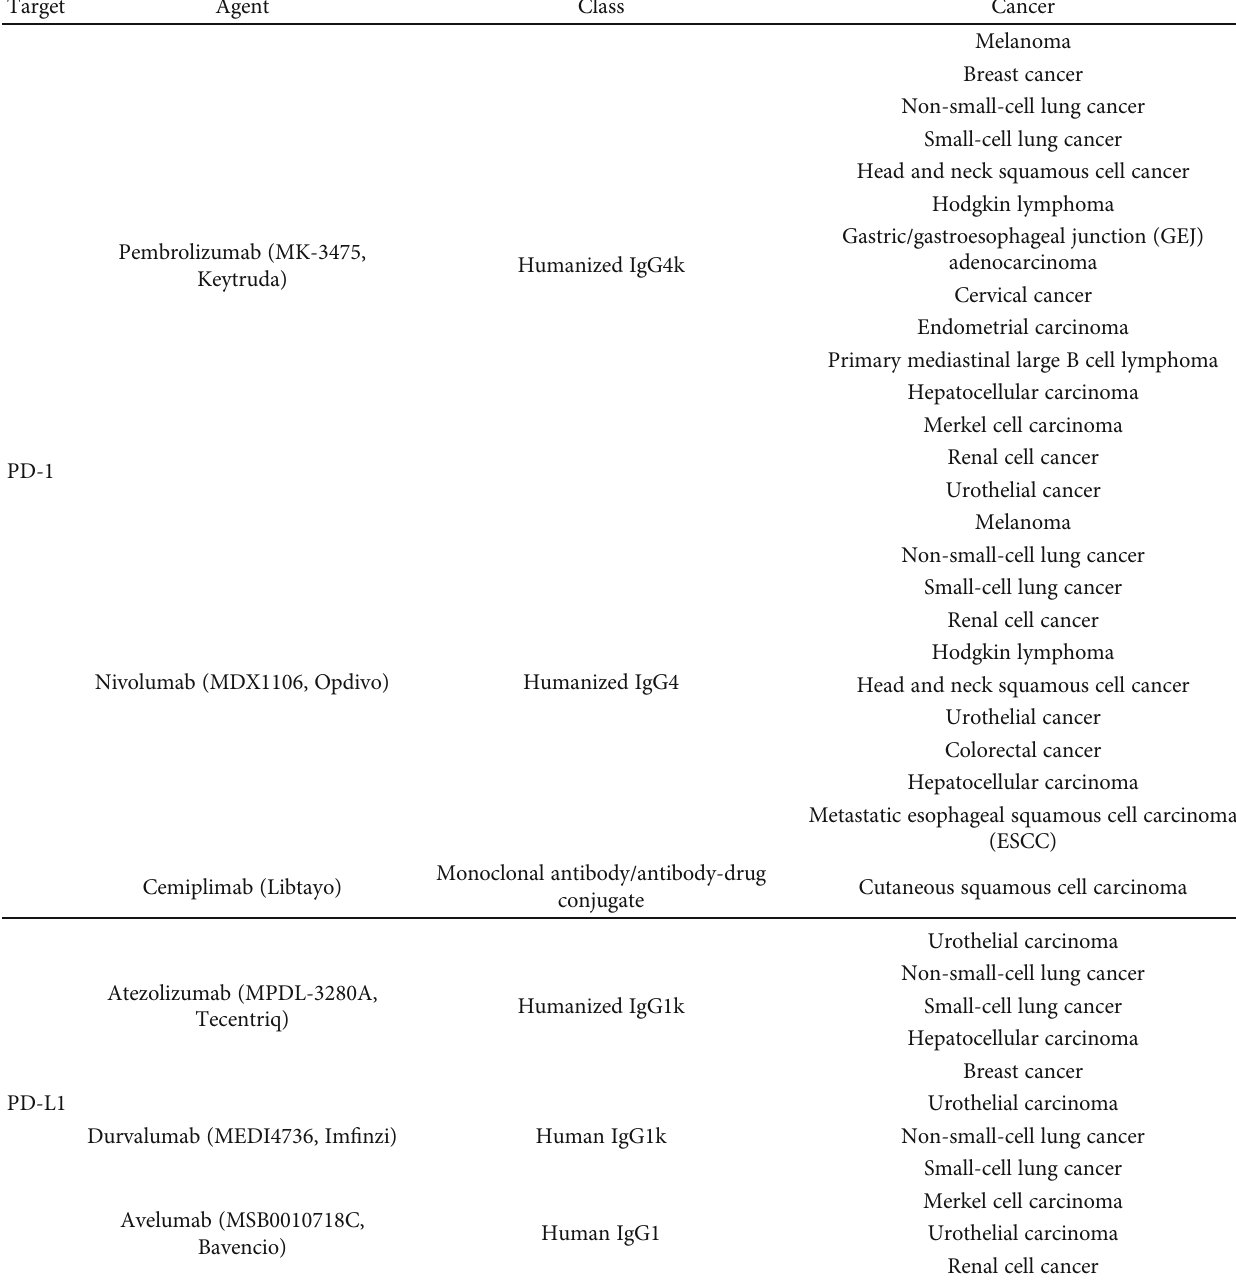
Table 2: FDA-approved PD-1/L1/2 inhibitors for various